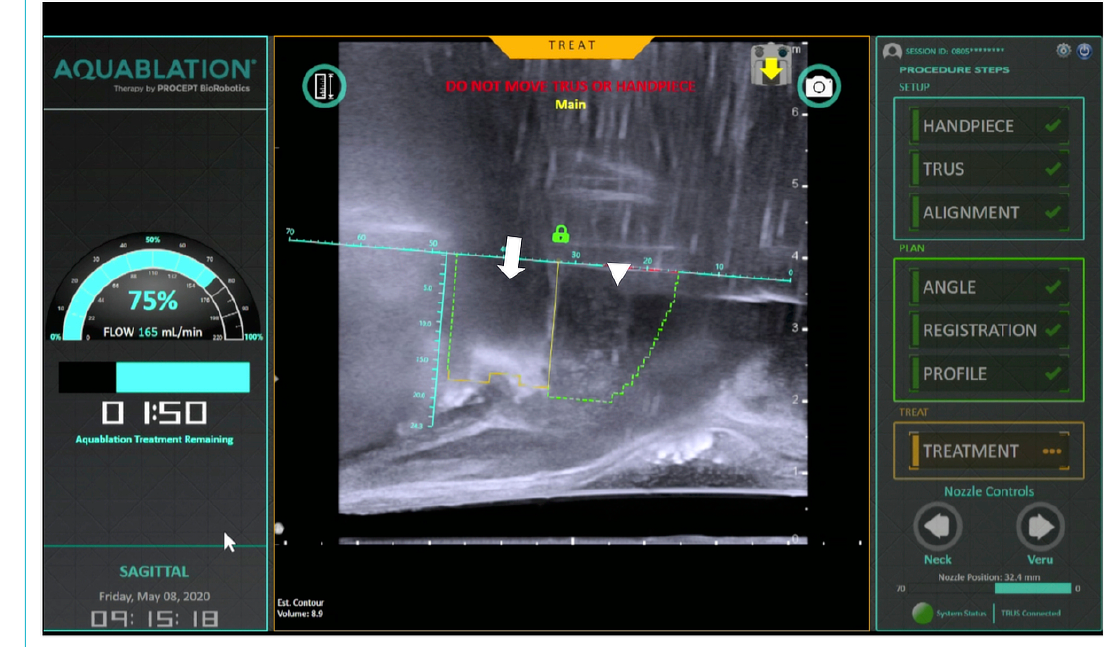
Figure 1: Aquablation. The AquaBeam system includes a planning unit, a robotic hand-piece and a surgeon console. By means of a high- pressure saline stream, parenchymal tissue of the prostate (arrowhead) is removed (arrow) endoscopically through a heat-free mechanism called hydrodissection. The intervention is supported by live ultrasound guidance and the required depth and angle of the resection is planned out prior to the